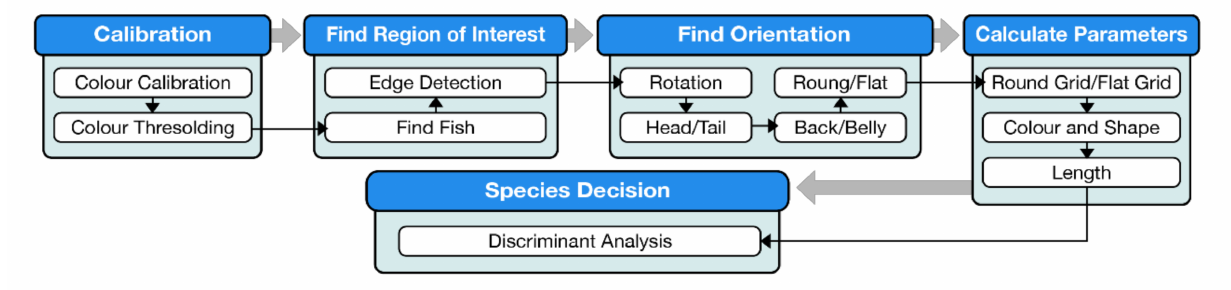
Figure 10. Flow chart showing basic step in the fish analysis software.